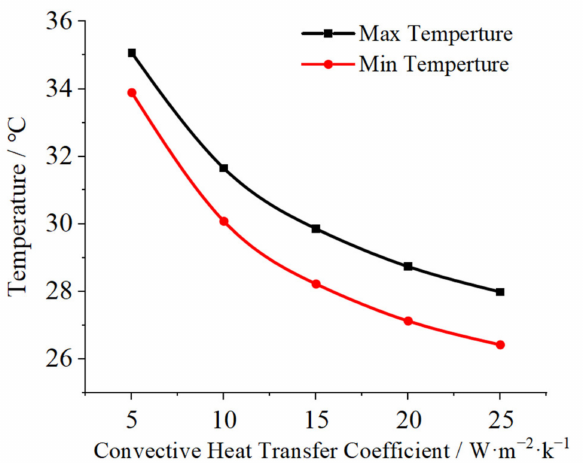
Figure 4. Sensitivity analysis of convective heat transfer